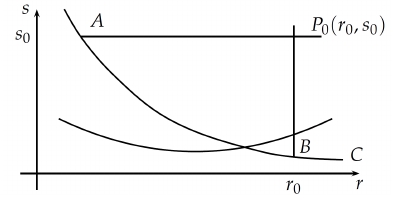
Figure 1. The Initial